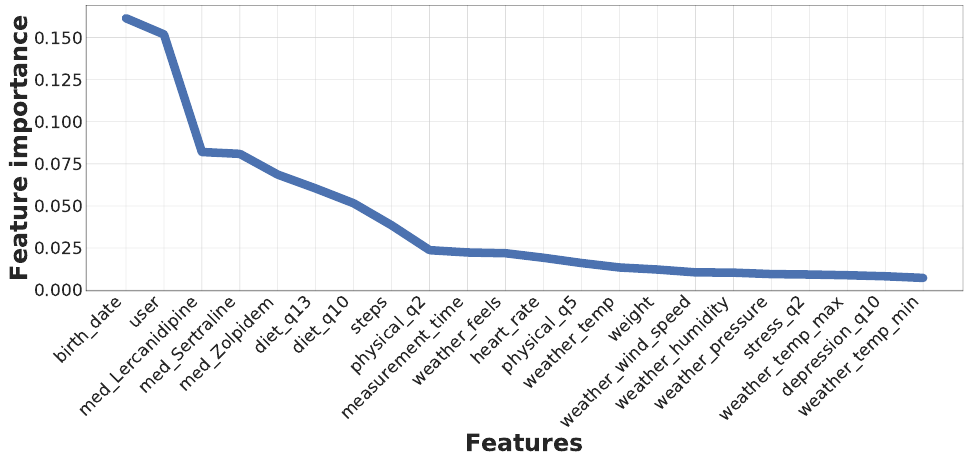
Figure 15. Feature importance after the application of Random Forest over the general